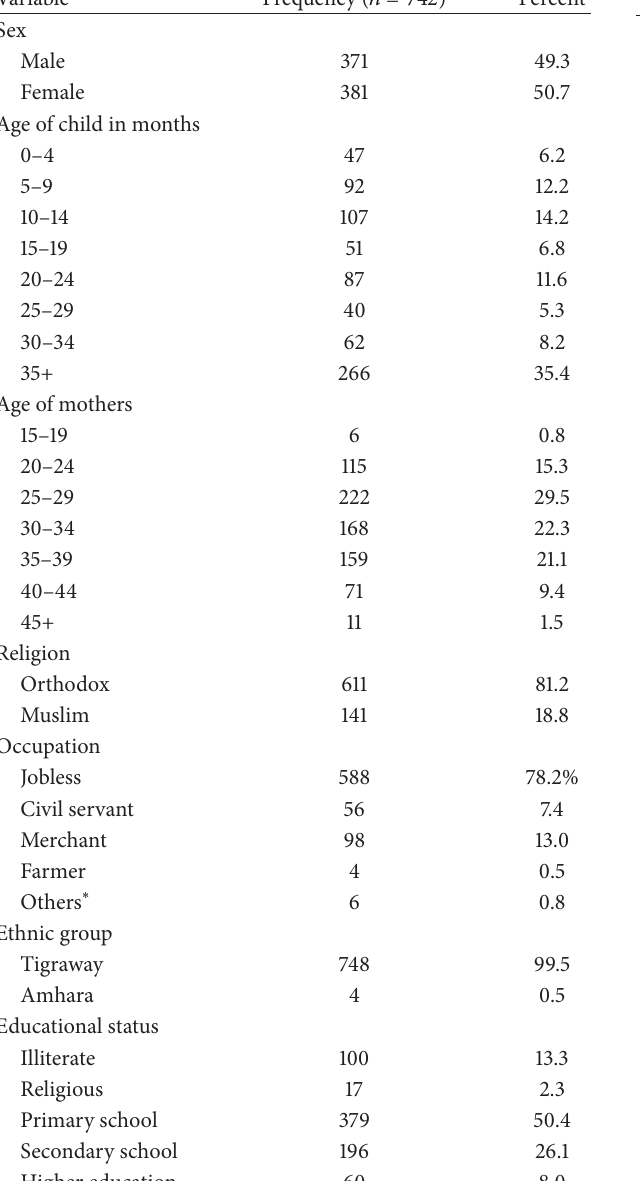
Table 1: Sociodemographic characteristics of children less than five years old in Axum Town, North Ethiopia, 2013.